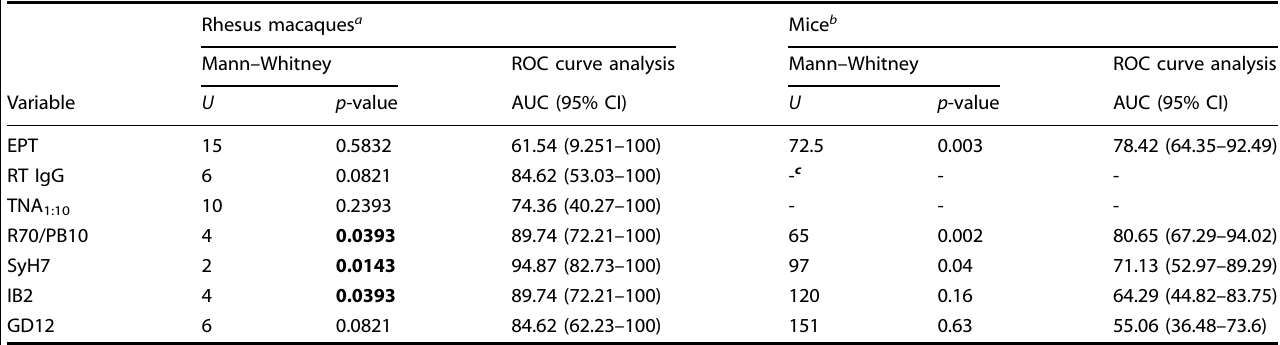
a RT challenge by aerosol; b RT challenge by intraperitoneal injection. Values reproduced from Van Slyke, 2020; c dash ( − ) indicates analyses was not conducted, as noted in text. The bold text highlights p -values <